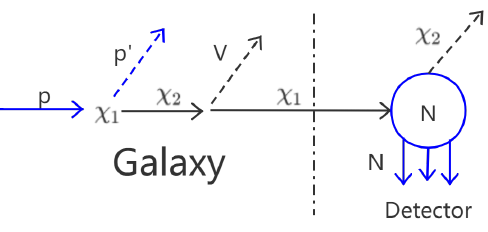
Figure 1. Cosmic ray accelerated inelastic DM detection scenario: p + χ 1 → p 0 + χ 2 → p 0 + χ 1 + V , where p denotes the CR proton or helium, and the prime is used to distinguish the same particles in the initial and final states. The inelastic DM χ state, respectively; V is the mediator between SM and DM; and N is the target nucleus inside the underground detector. By this mechanism, the final χ